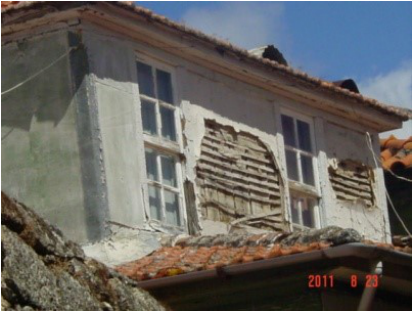
Figure 1: Tabique building and